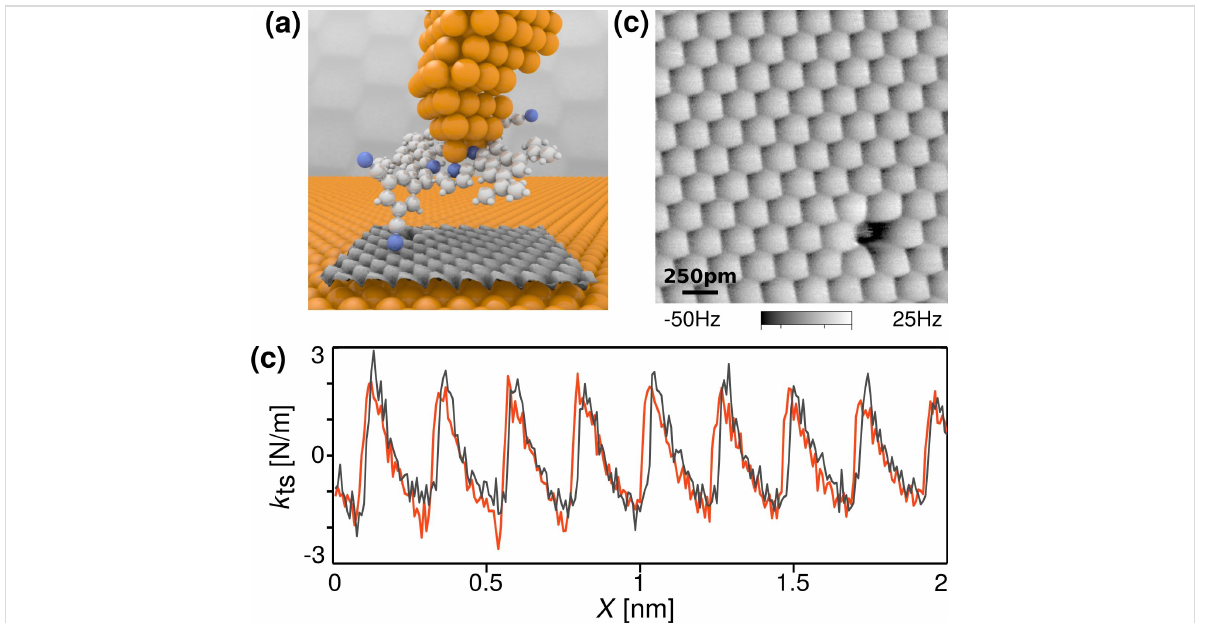
Figure 6: Single-molecule tribology. a) Schematic drawing of the experiment: A single porphyrin molecule is attached to the AFM apex and dragged over a Cu(111) surface. b) By recording the mechanical response of the sliding molecule, the AFM scan maps the atomic lattice of Cu(111). c) Tip–sample stiffness trace extracted from the image showing a stick–slip modulation. Reprinted with permission from [183], copyright 2016 Amer- ican Chemical